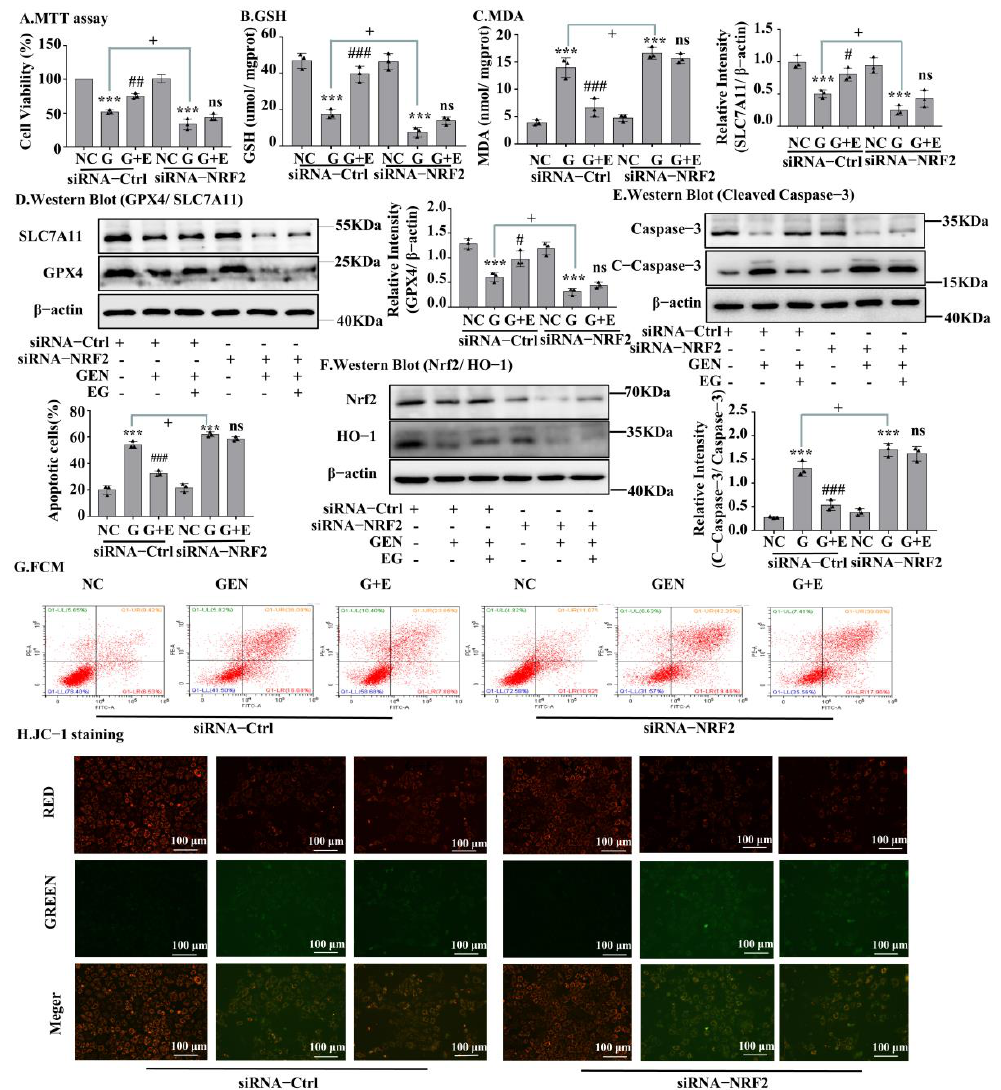
Figure 6. The silent Nrf2 prevented EG from improving GEN-induced apoptosis and ferroptosis. ( A ) NRK-52E cells were treated with siRNA-Nrf2 or negative control siRNA (siRNA-Ctrl) for 24 H. Cell viability was determined by using MTT assay, by using NC group as control. ( B ) GHS level in NRK-52E cells. ( C ) MDA level in NRK-52E cells. ( D ) Western blot analysis of GPX4 and SLC7A11 in NRK-52E cells. ( E ) Western blot analysis of Nrf2 and HO-1 in NRK-52E cells. ( F ) Western blot analysis of cleaved-caspase-3 in NRK-52E cells. ( G ) Apoptosis of NRK-52E cells was analysed by flow cytometry. ( H ) The JC-1 staining of NRK-52E cells showed that after NRK-52E cells silenced Nrf2 , EG (25 μM) combined with GEN (3 mM) did not improve the red fluorescence reduction and green fluorescence enhancement caused by GEN compared with GEN (3 mM) alone. Scale bars = 100 μm. In vitro data was expressed as mean ± SEM of three independent experiments. *** p < 0.001 vs. control group; # p < 0.05, ## p < 0.01, ### p < 0.001 vs. GEN group; + p < 0.05 siRNA-Ctrl GEN group vs. siRNA-Nrf2 GEN group.